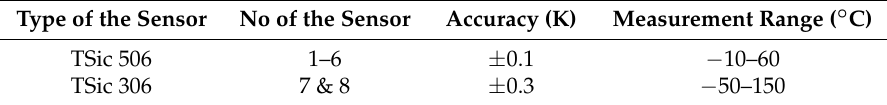
Figure 4. Location of the temperature sensors. Table 1. Basic characteristics of temperature sensors.